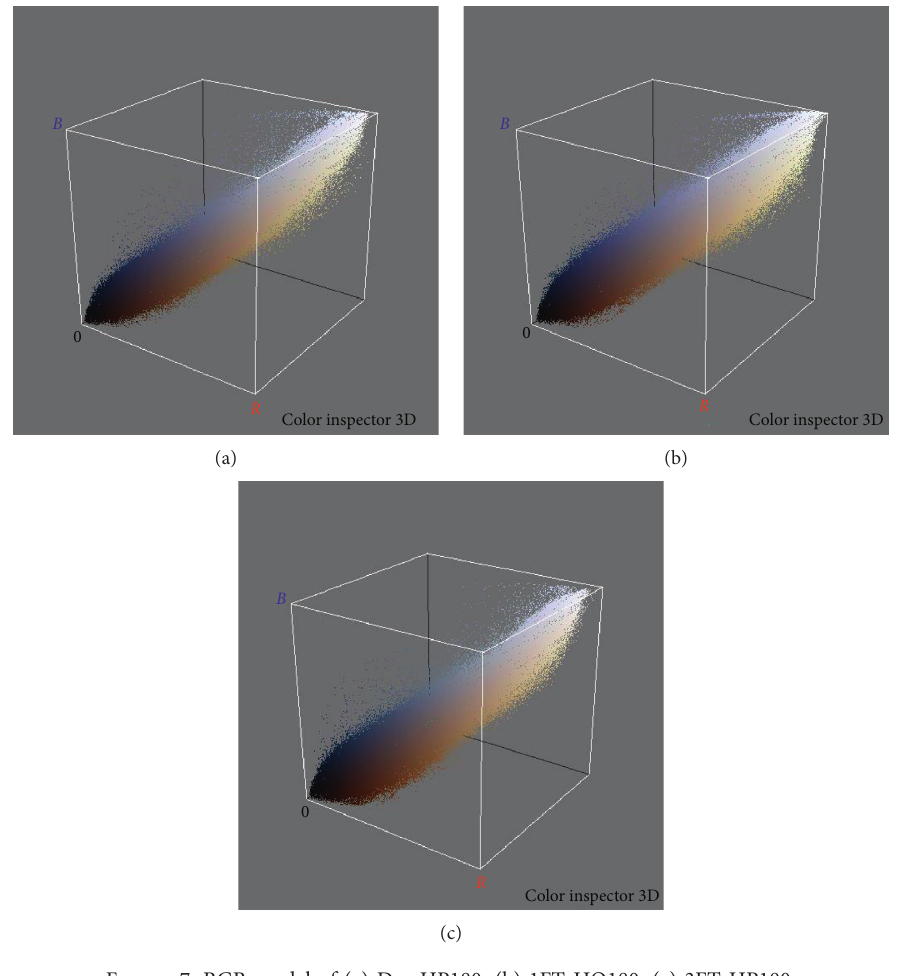
Figure 7: RGB-model of (a) Dry-HP180, (b) 1FT-HO180, (c) 3FT-HP180. Table 5: Datasets of asphalt mixture